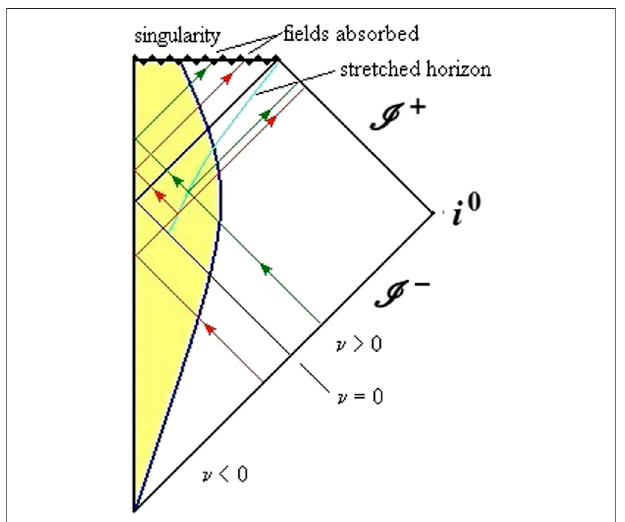
FIGURE 1 | Penrose diagram for black hole and the stretched